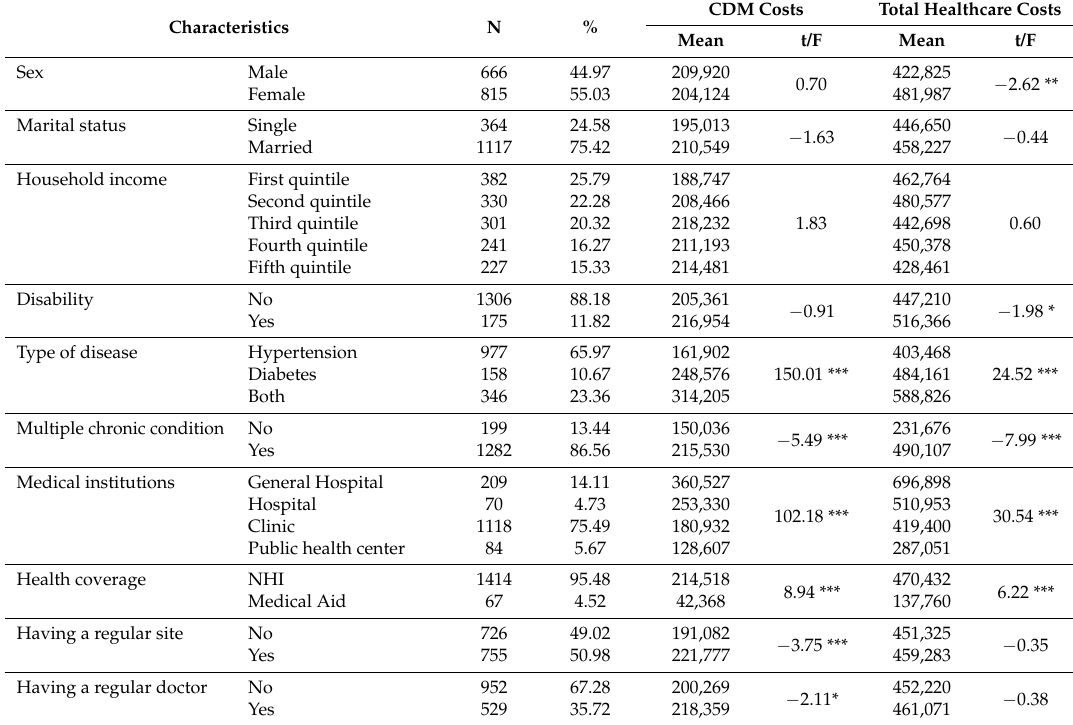
Table 1. Characteristics of study population and average differences in annual healthcare costs, 2012 (N =